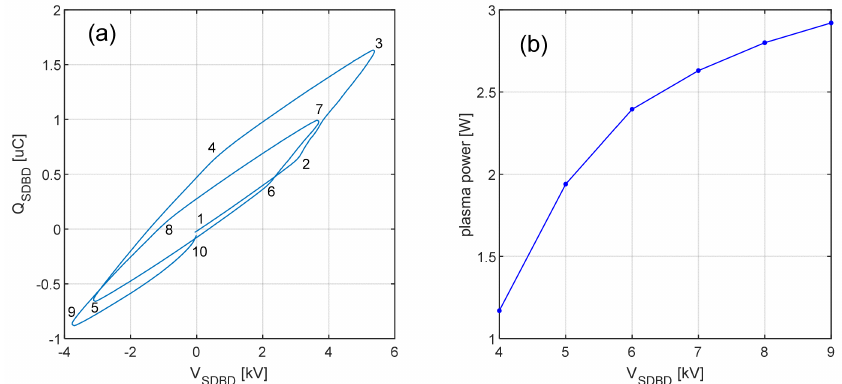
Figure 6. ( a ) Lissajous figure of the SDBD plasma for the two-cycle waveform at 8 kV pp nominal voltage; ( b ) power calculation for nominal voltages 4–9 kV pp . The numbers are used as references for Figure 5 to highlight specific key points linked to the